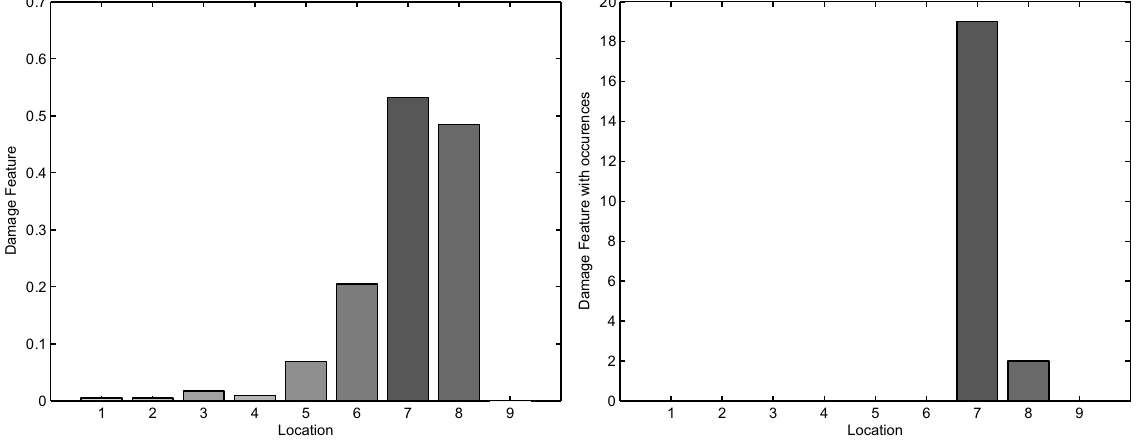
Fig. 19. Damage feature without and with occurrences for damaged structure and changing loading conditions, frequency range 7–9